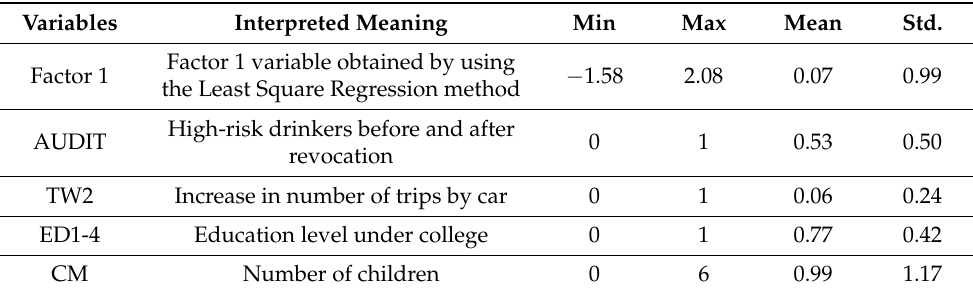
Table 12. Variables used in the double-hurdle model of motorbike drivers’ willingness to use alcohol